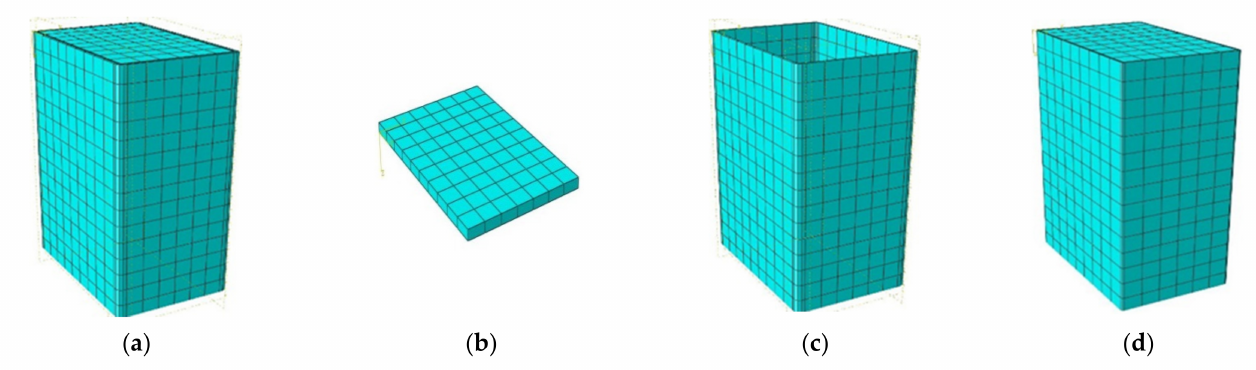
Figure 2. Mesh generation of the FE models: ( a ) FE model, ( b ) loading plate, ( c ) cold-formed steel tube, and ( d ) core